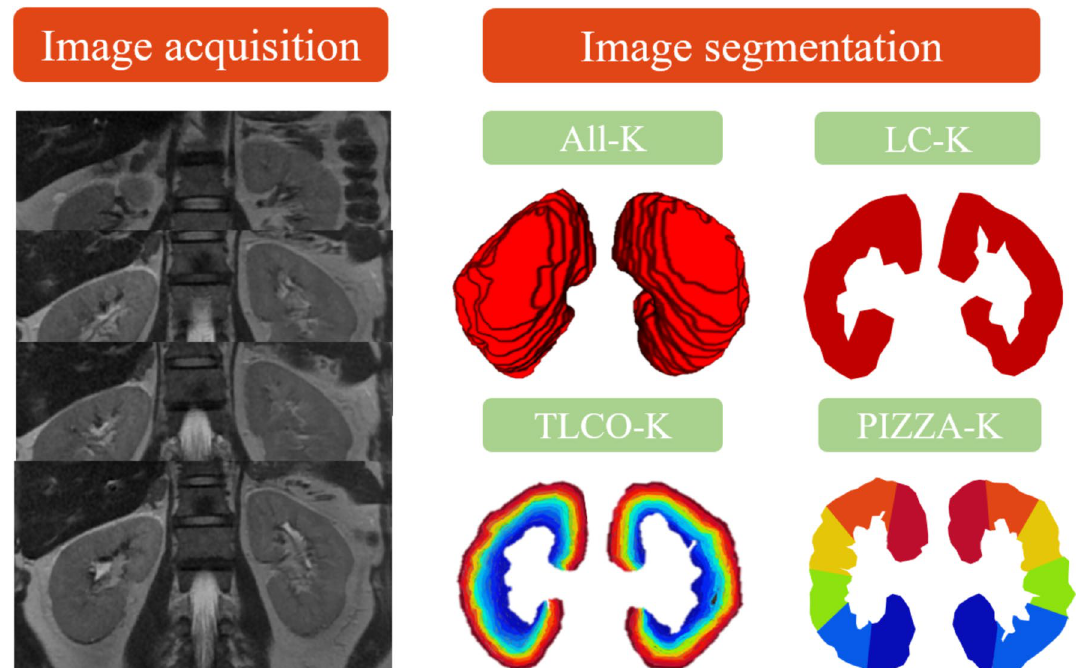
Fig. 1 The four segmentation methods on the model construction for renal function evaluation. Note: All-K, all coronal slices of kidneys; LC-K, the largest coronal slices of kidneys; TLCO-K, 12 layers of the largest coronal slices of kidneys; PIZZA, 6 pieces of the largest coronal slices of